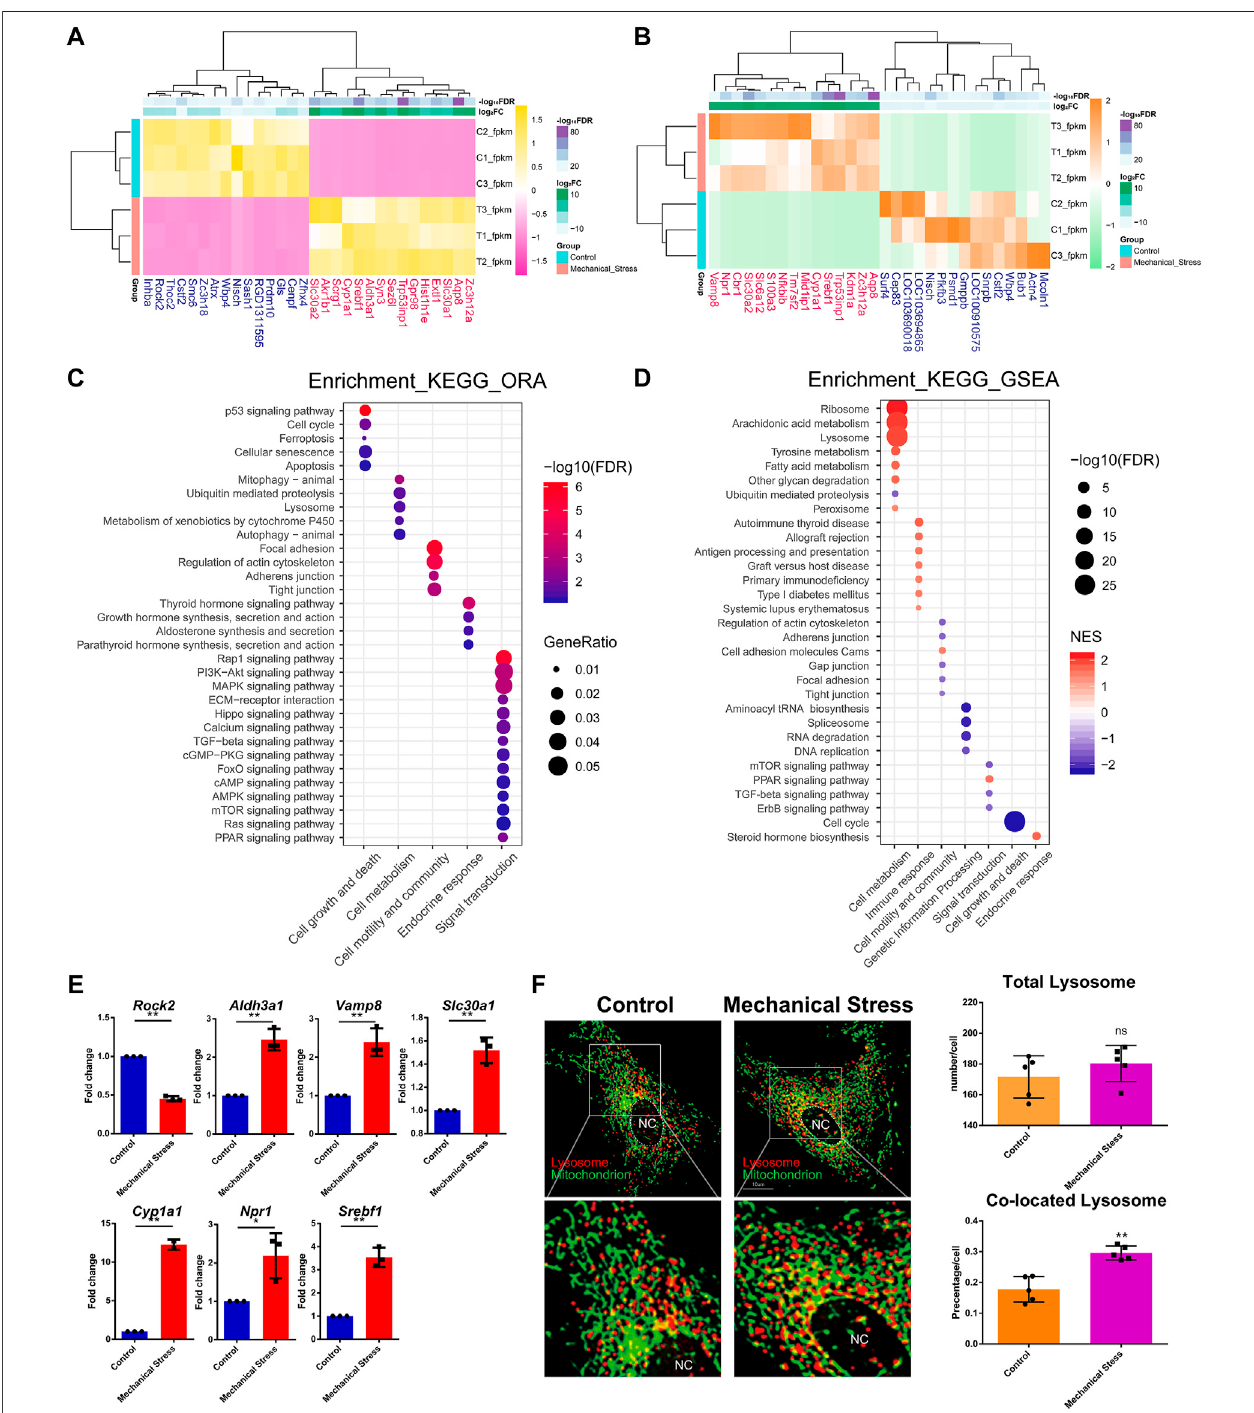
FIGURE 2 | The mRNA transcriptome reveals the critical mechanical stress-responsive genes and signaling pathways. (A) Top 15 up- or downregulated genes in the rank of FDR. (B) Top 15 up- or downregulated genes in the rank of log2FC. (C) KEGG pathway analysis of DEMs by ORA method. The relevant pathways are assigned into fi ve groups, namely, cell growth and death, cell metabolism, cell motility and community, endocrine response, and signaling transduction. The color and sizeofdotrepresent FDRand GeneRatioofthecorrespondingKEGGpathway, respectively.FDR,falsediscoveryrate, p -valueestimatedbyone-wayANOVAand adjusted by the Benjamini – Hochberg method. GeneRatio indicates the gene number ratioin each KEGG pathway. (D) KEGG pathway analysis of total gene expression pro fi lebytheGSEAmethod.Therelevantpathwaysareassignedintosevengroups,namely,cellgrowthanddeath,cellmetabolism,cellmotilityandcommunity,genetic information processing, endocrine response, immune response, and signaling transduction. The color and size of dot represent NES and FDR of the corresponding